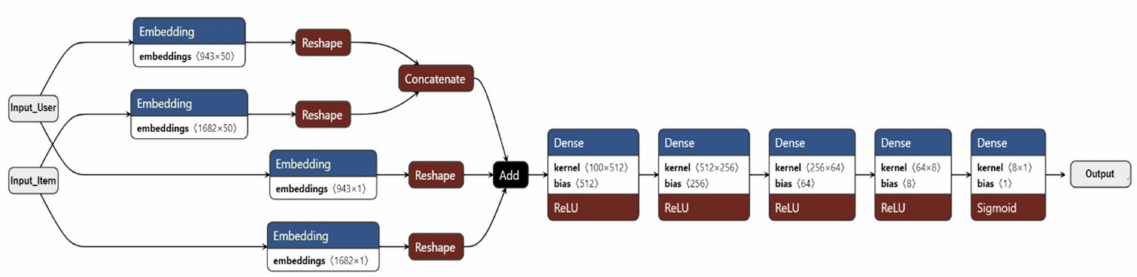
Figure 2. Architecture of our Deep Neural Network